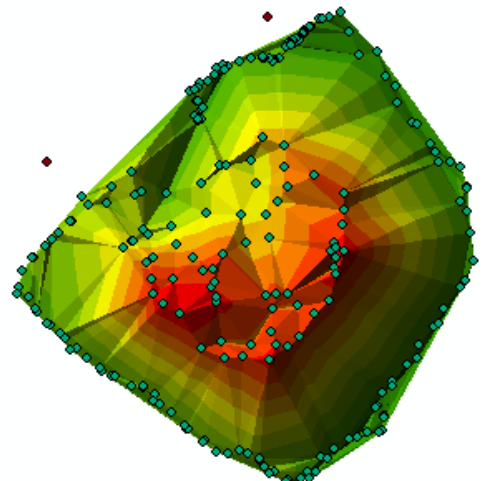
Figure 2. TIN Surface from TST data top view